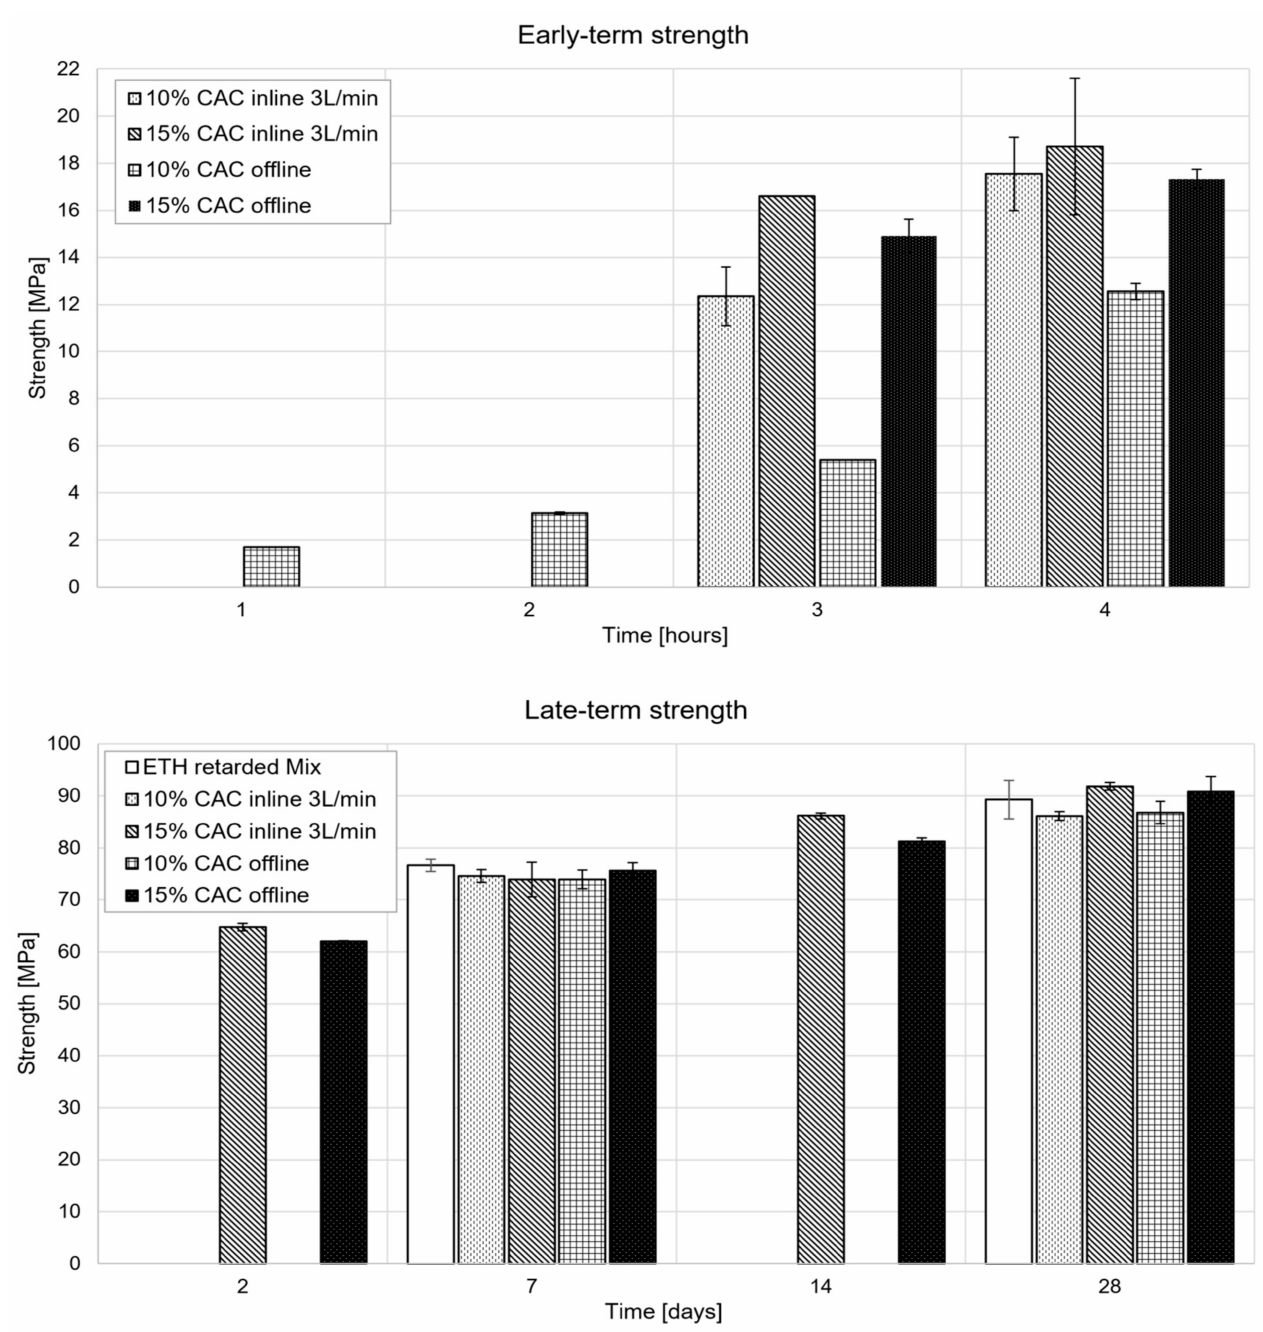
Figure 6. Compressive strength measurements in periods II ( top ) and III ( bottom ). The results present an average of the strengths with corresponding error bars obtained from several samples collected from at least two mixes independently prepared for each